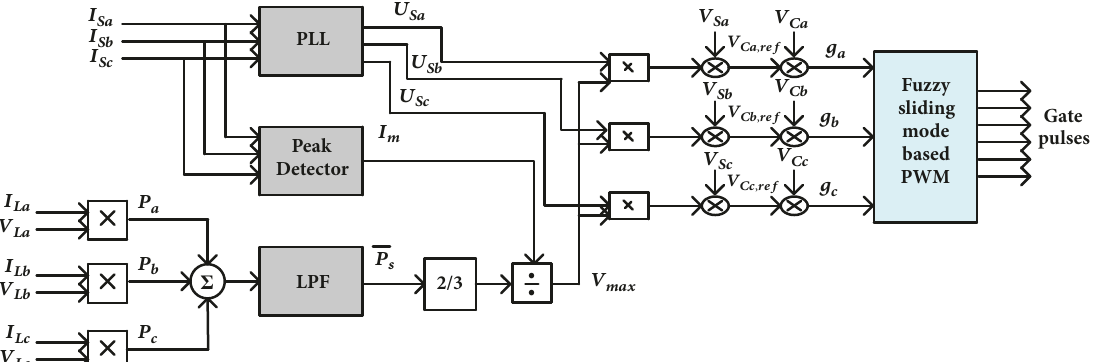
Figure 3: Control strategy of series filter using FSMPWM